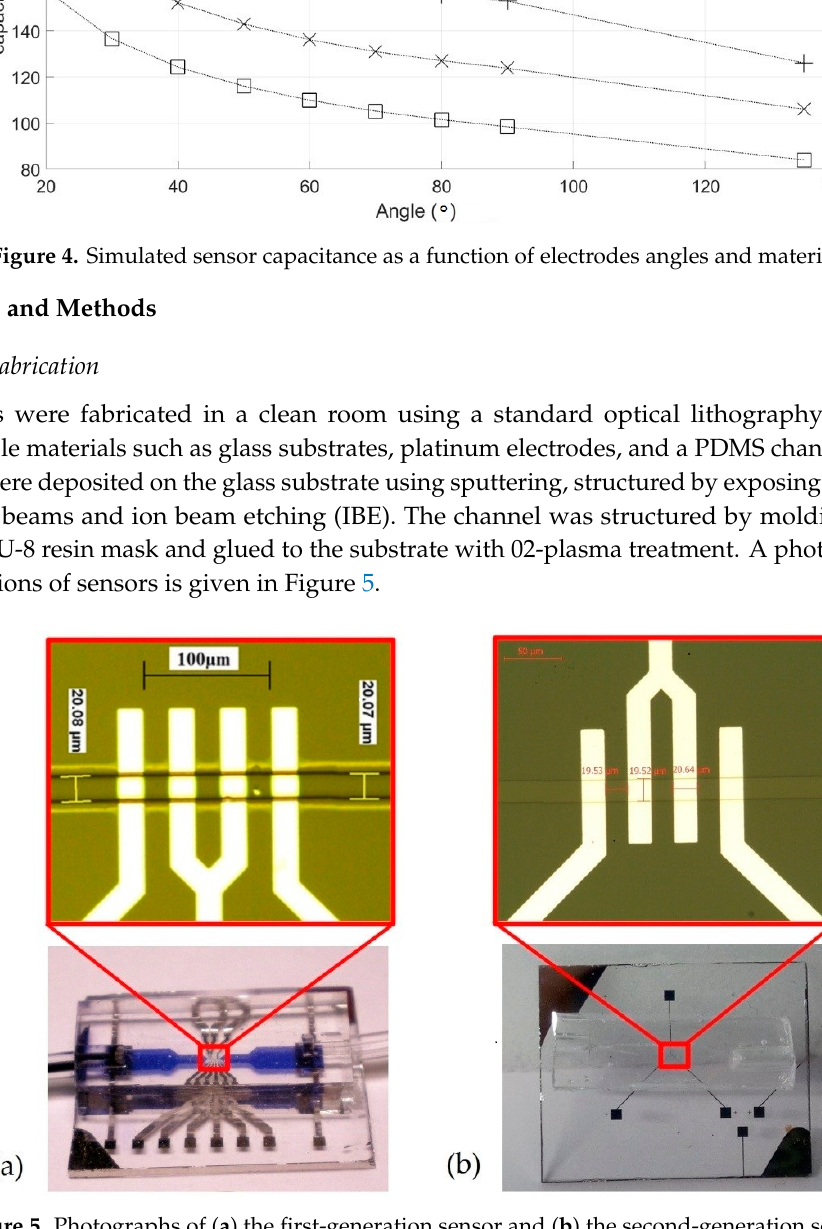
Figure 5. Photographs of ( a ) the first-generation sensor and ( b ) the second-generation sensor.